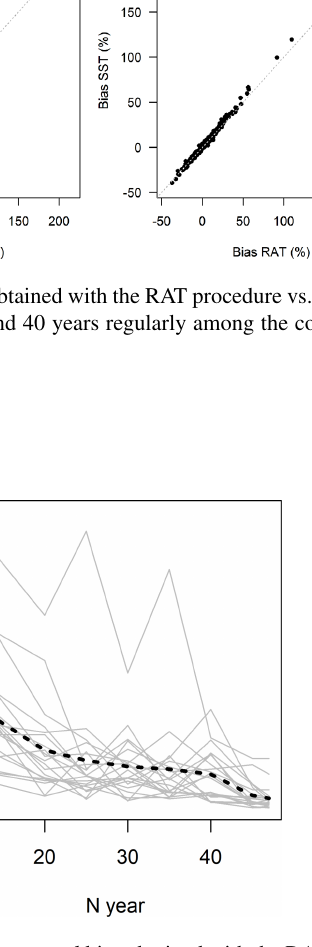
Figure A5. RMSD between annual bias obtained with the RAT pro- cedure and with the leave-one-out SST for different calibration pe- riod lengths for each catchment. The dotted line represents the mean RMSD for all catchments. Each grey line represents 1 of the 21